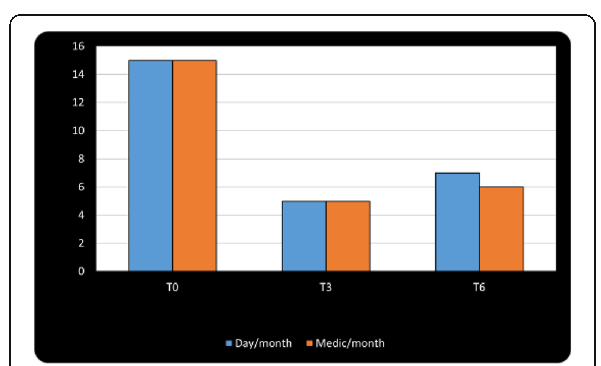
Fig. 2 (abstract 174). See text for